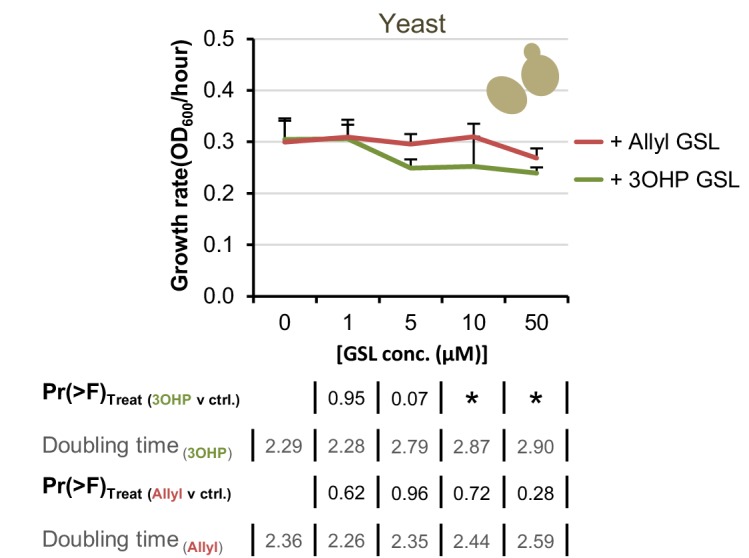
Yeast response to 3OHP suggests a conserved target throughout eukaryotes.Yeast growth in YPD media supplemented with none or increasing levels of 3OHP or Allyl. The hourly OD600 increase is plotted against each concentration of either Allyl or 3OHP. The least squared means ±SE over four replicates are presented (n = 4). ANOVA was utilized to test for a significant effect of GLS treatment individually for each concentration of 3OHP and Allyl.